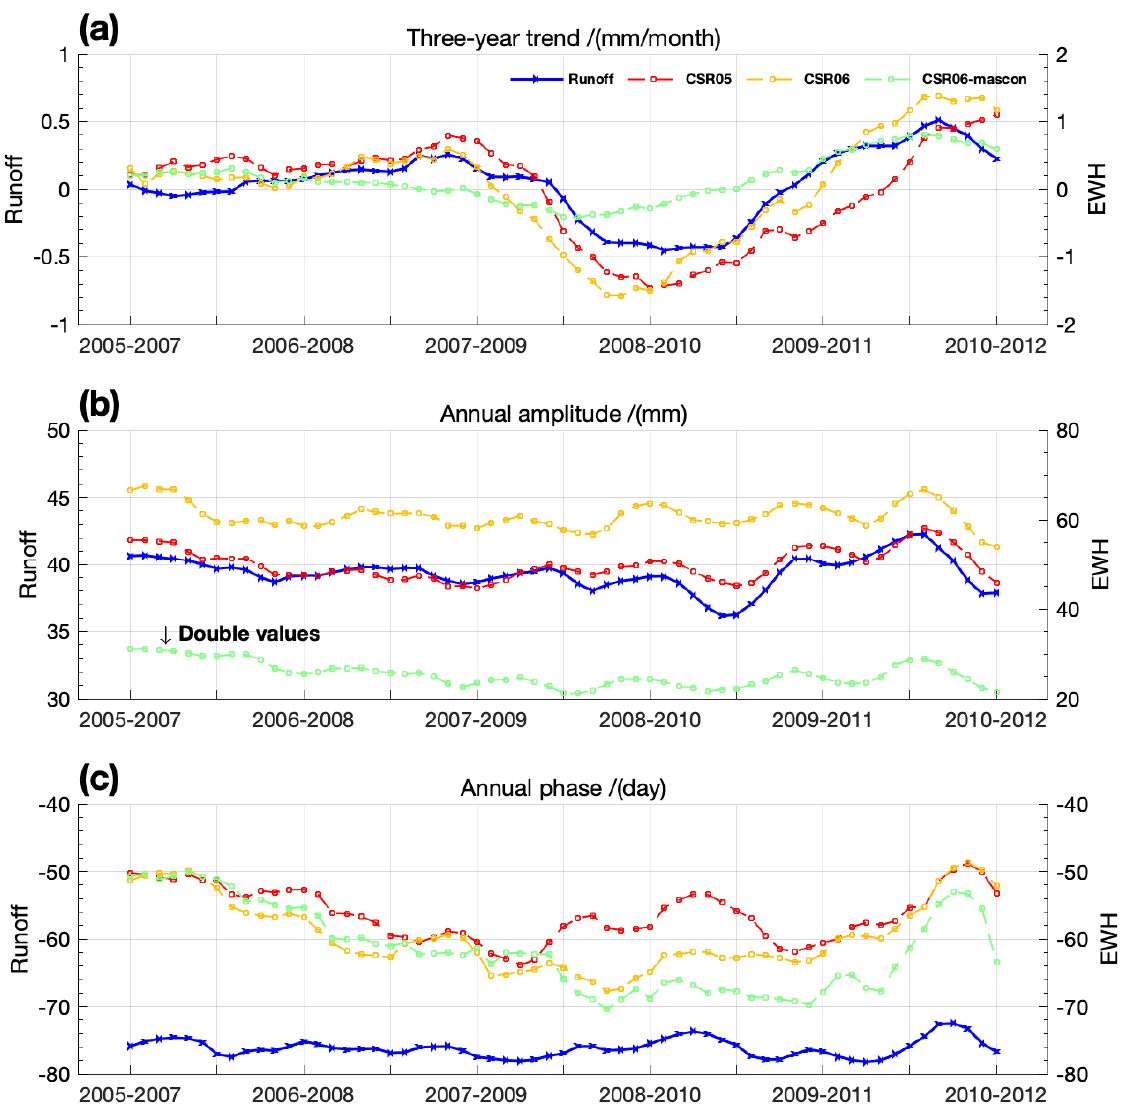
Figure 5. Time series of three versions of GRACE EWHs against runoff employing three-year rolling windows during 2005–2012 in terms of ( a ) three-year trend, ( b ) annual amplitude and ( c ) annual phase. Note that the annual amplitude of CSR06-mascon was doubled in ( b ). The x-axis labels each complete three-year period. For example, “2005–2007” represents the time period between January 2005 and December 2007. 36.15 to 42.28 mm, with the mean annual amplitude of ~49.9 mm and ~61.0 mm for CSR05 and CSR06, respectively, which values are approximately four times larger than that of CSR06 ‐ mascon (i.e., ~12.7 mm). These numerical differences in GRACE are mostly due to the different versions of the non ‐ tidal oceanic and atmospheric model (i.e., AOD1B), cor ‐ rected for CSR05 and CSR06, and the design of the regularization matrices for continental and oceanic areas for CSR06 ‐ mascon. The peaks and troughs of three EWHs are about 1~2 months later than the runoff time series. The PCCs between EWH and runoff in terms of annual amplitude are all higher than 0.60 (Table 1), and CSR05 EWH attains the highest PCC of 0.78. On the contrary, the annual phase variations for the three EWHs are shown to be inconsistent with that of runoff, particularly in the ENSO event in 2010. During the El